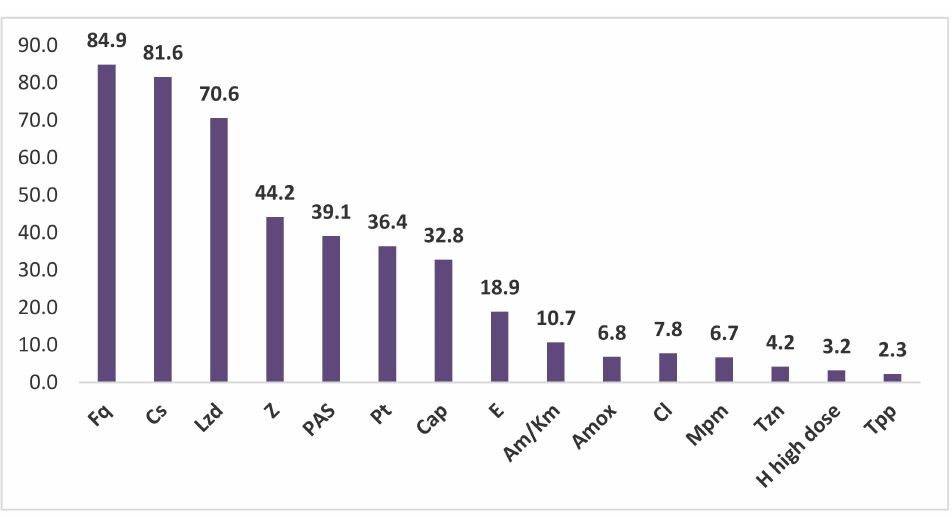
Figure 3. Using drugs in therapy regimens together with bedaquiline